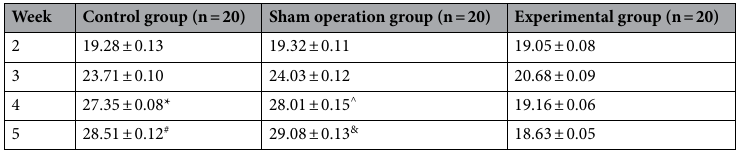
Table 1. Daily food-intake (g). * P < 0.05 compared with the experimental group, # P < 0.05 compared with the experimental group, ^ P < 0.05 compared with the experimental group, & P < 0.05 compared with the experimental group. From the second week, the rats in experimental group began to eat less, and the daily food-intake decreased obviously compared with that in control group and sham operation group. (SPSS22.0 http://www.downx ia.com/downi nfo/16552 3.html).